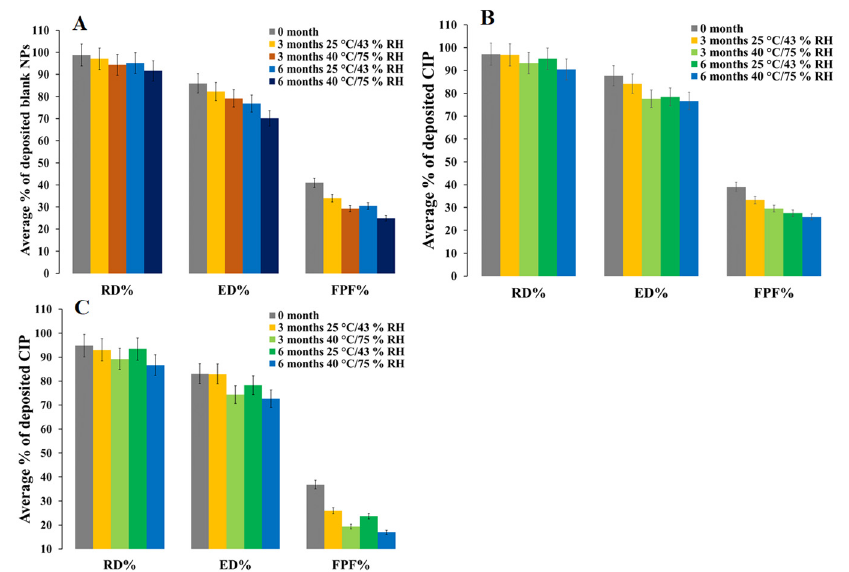
Figure 8. In vitro aerosol performance of blank and CIP-loaded PEtOx NPs before and after 3 and 6 months of storage at 25 °C/43% RH and 40 °C/75% RH; ( A ) blank PEtOx NPs; ( B ) 5 mg CIP-loaded PEtOx NPs; ( C ) 25 mg CIP-loaded PEtOx NPs.